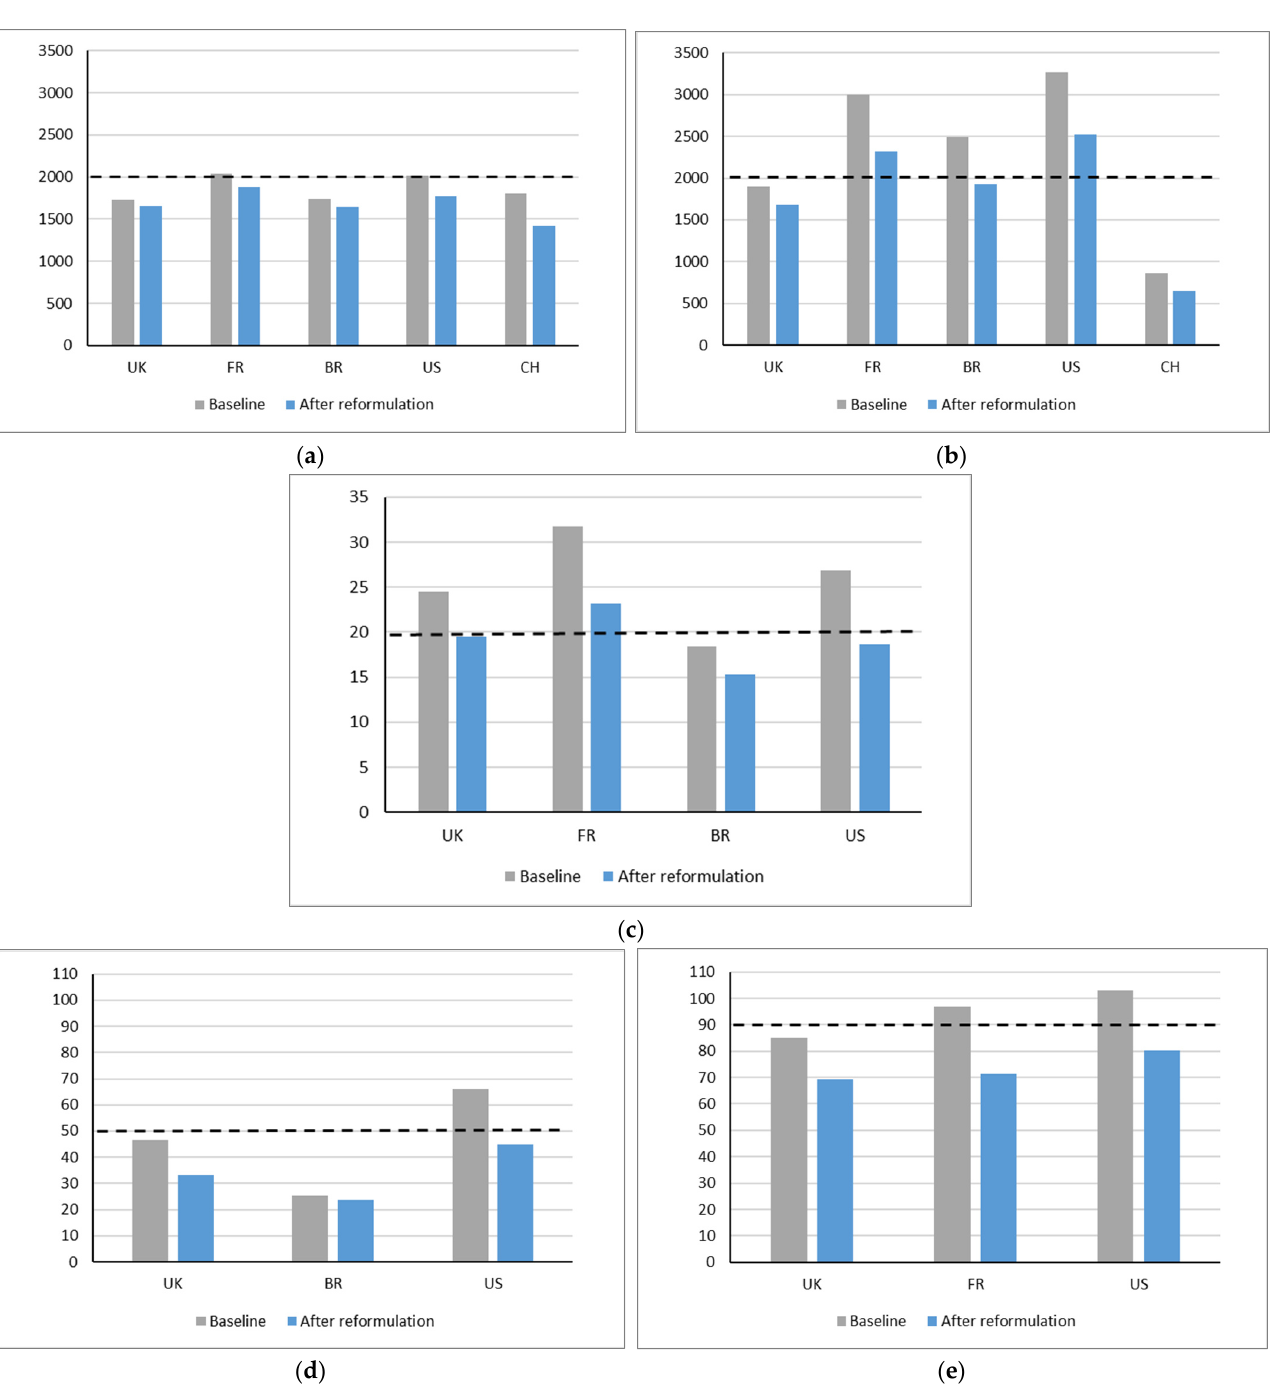
Figure 2. Mean population intakes at baseline and after hypothetical reformulation for ( a ) Energy (kcal), ( b ) Sodium (mg), ( c ) SAFA (g), ( d ) Added sugars (g), and ( e ) Total sugars (g). The grey line represents the WHO nutrient guideline (Table 1). For total sugars, 90 g/day was used as guideline in line with EU regulation for daily value labelling on-pack [11].